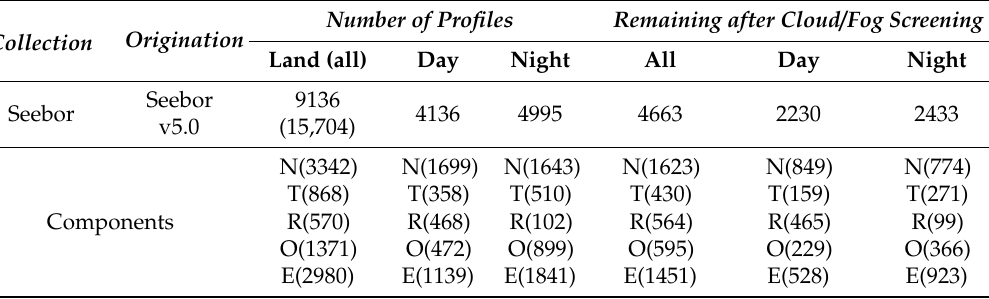
Table 2. Details for profile collection used in the simulation